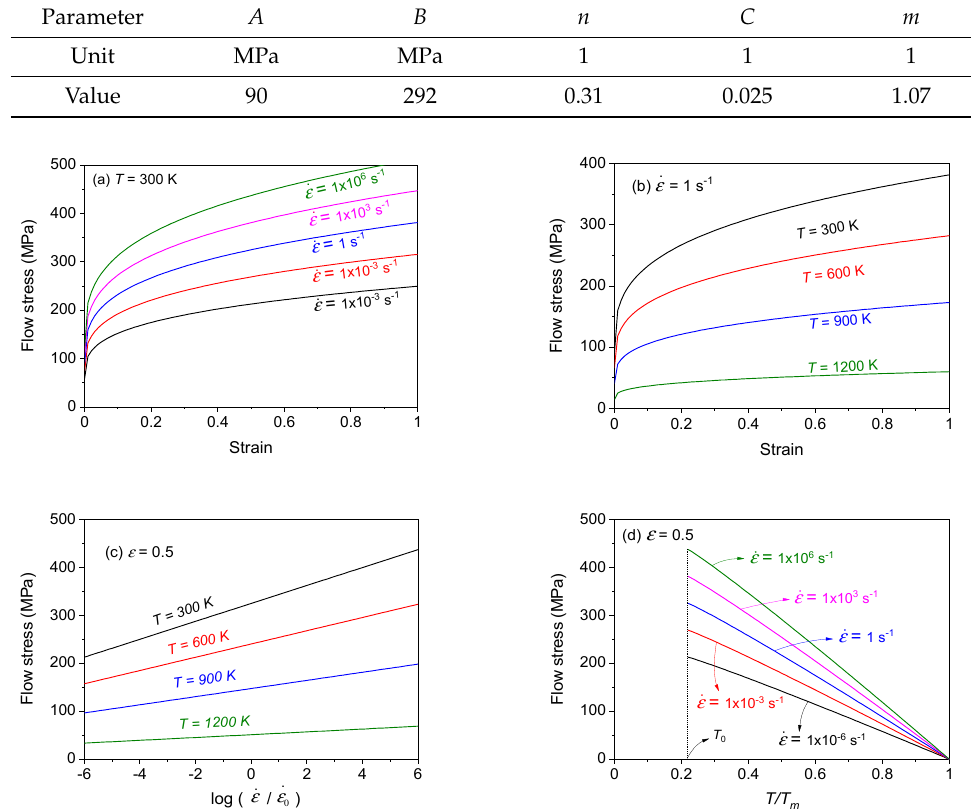
Figure 10. Flow stress–strain curves of OFHC copper predicted using the JC model ( a ) at 300 K for different strain rates and ( b ) at 𝜀(cid:4662) = 1 for different temperatures. Change in flow stress at 𝜀 = 0.5 ( c ) with log ( 𝜀(cid:4662) / 𝜀(cid:4662) (cid:2868) ) for different temperatures and ( d ) with T / T m for different strain rates.